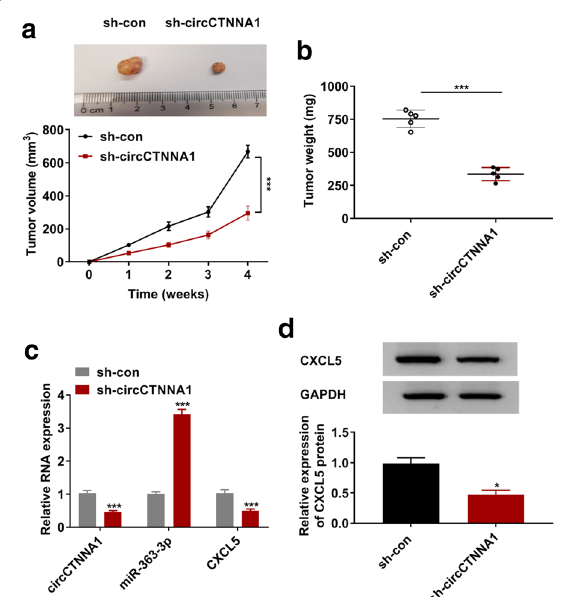
Fig. 7 CircCTNNA1 knockdown inhibited CRC tumorigenesis in vivo . SW620 cells transfected with sh-con or sh-circCTNNA1 were injected into nude mice. Tumor volume ( a ) and tumor weight ( b ) in each group were determined. c The expression levels of circCTNNA1, miR-363-3p and CXCL5 in the tumor tissues of each group were detected using qRT-PCR. d The protein expression of CXCL5 in the tumor tissues of each group was measured using WB analysis. * p < 0.05, *** p <